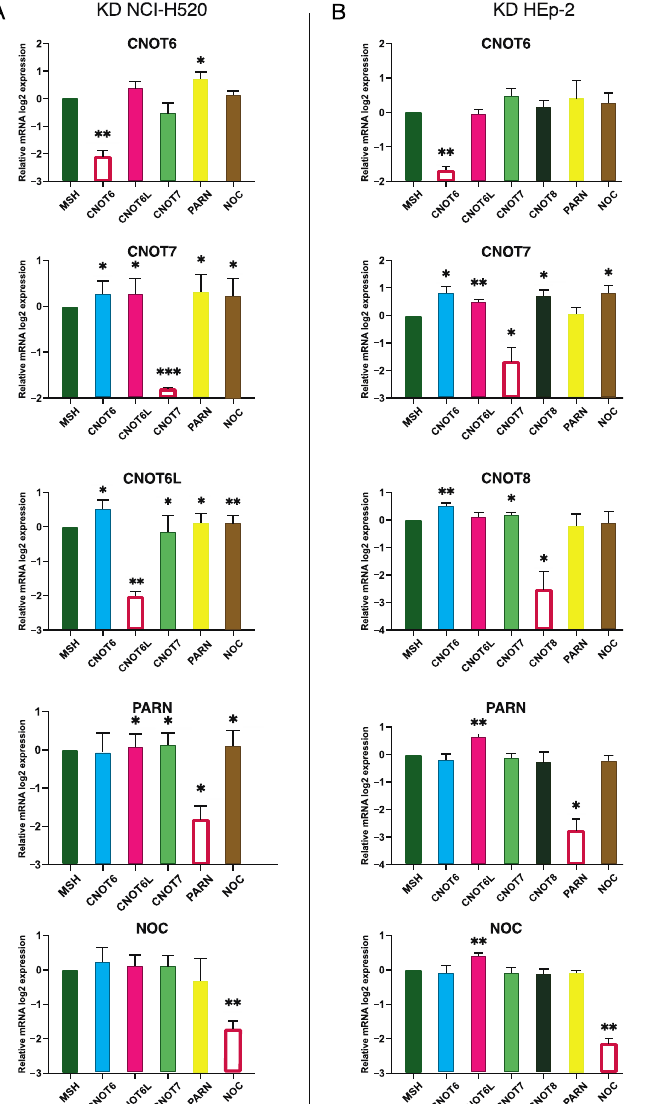
Figure 5. The silencing of a deadenylase affects the expression of other deadenylases. The levels of deadenylases were measured with RT-qPCR analysis following silencing of one deadenylase at a time in NCI-H520 ( A ) and in HEp-2 cells ( B ). The levels of the silenced enzyme are indicated with a red-outlined white column. MSH, control levels from cells transfected with non-targeting shRNA. * p ≤ 0.05; ** p ≤